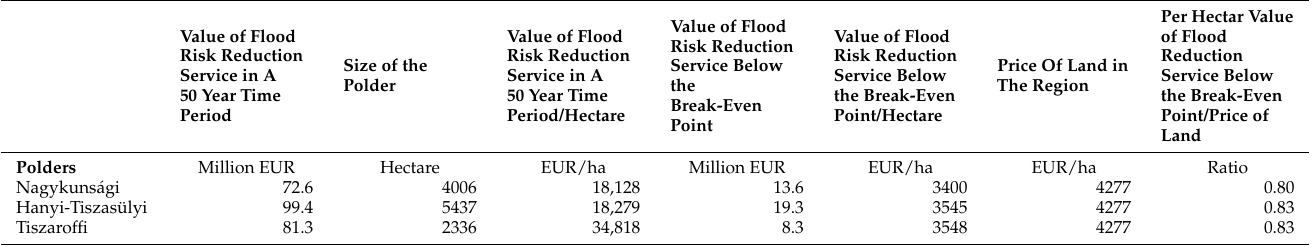
Table 1. Flood peak polder area economic performance. Legend: EUR values calculated by the